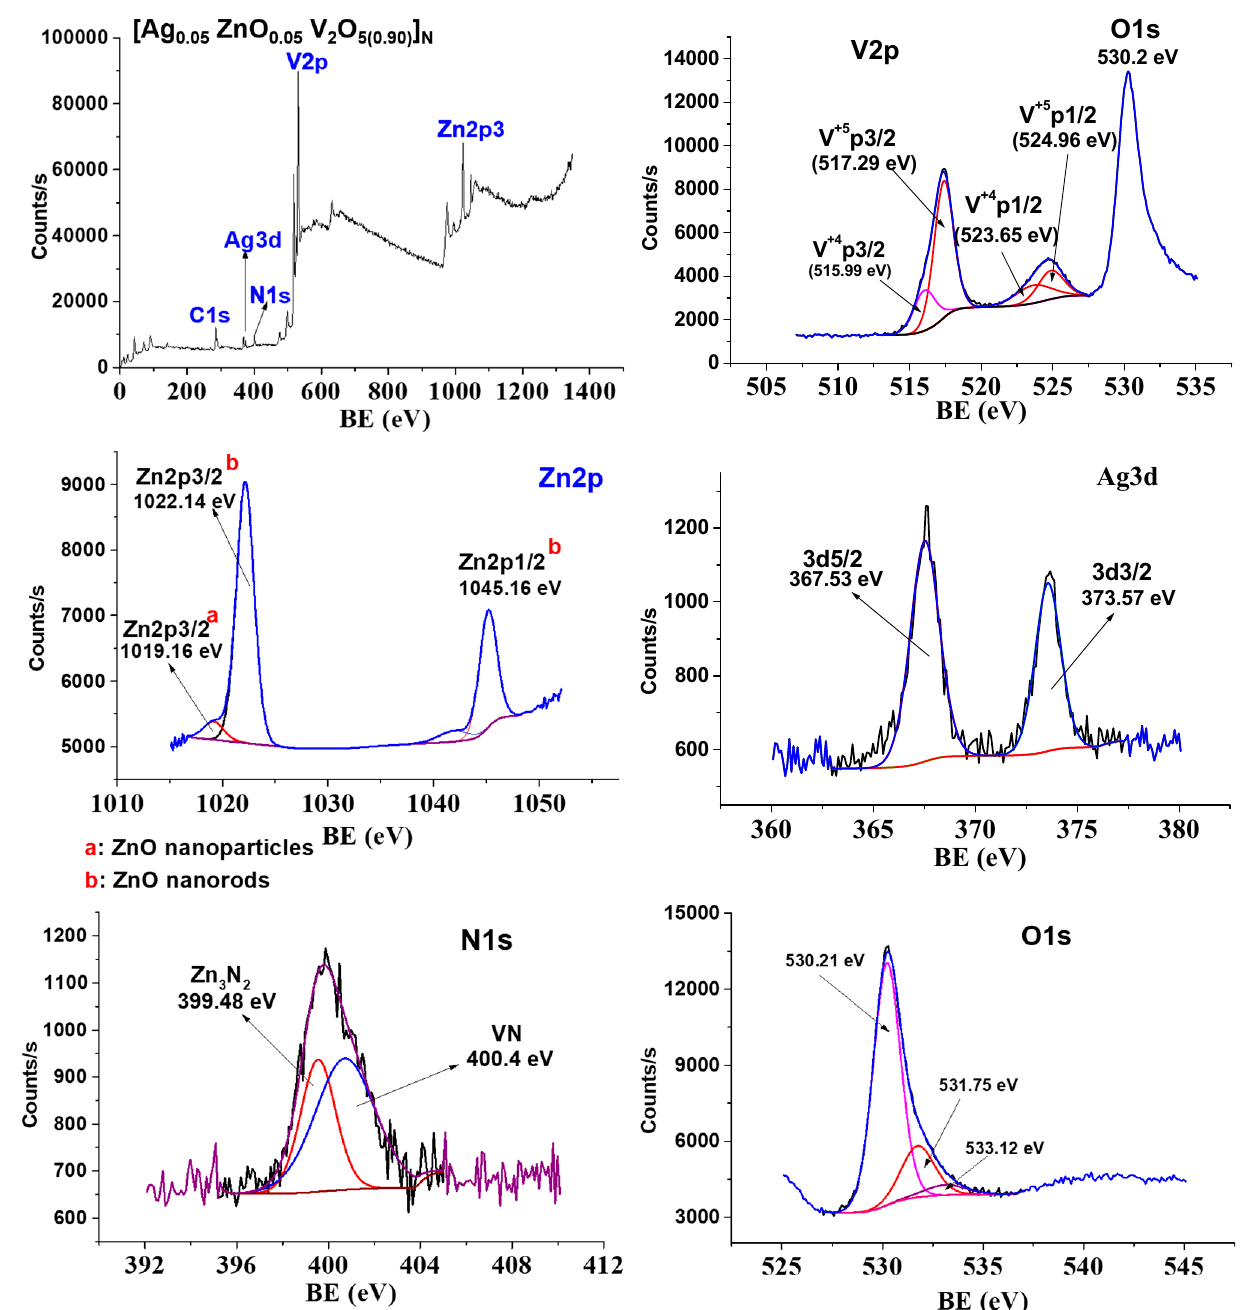
Figure 4. XP-spectra of [Ag 0.05 ZnO 0.05 V 2 O 5(0.90) ] N and its constituent metallic species. SEM images of [Ag 0.05 ZnO 0.05 V 2 O 5(0.90) ] and [Ag 0.05 ZnO 0.05 V 2 O 5(0.90) ] N are shown in Figure 5a,b. The lattice of [Ag 0.05 ZnO 0.05 V 2 O 5(0.90) ] appears more ordered and homogenous as a tri-constitute composite than that of [Ag 0.05 ZnO 0.05 V 2 O 5(0.90) ] N , indicating the destruc- tion of the crystal system by N-doping (cf. Figure 2). In the SEM image of [Ag 0.05 ZnO 0.05 V 2 O 5(0.90) ], nanofibers with lengths between 5 and 10 µm are dispersed in particles with a wide range of sizes between 0.5 and 5 µm. The SEM profile of [Ag 0.05 ZnO 0.05 V 2 O 5(0.90) ] N displays surface-large cavities ranging from 10 to 70 µm. The compatibility between VN and Zn 3 N 2 is indicated and repels the metallic Ag onto the cavity’s mouth.